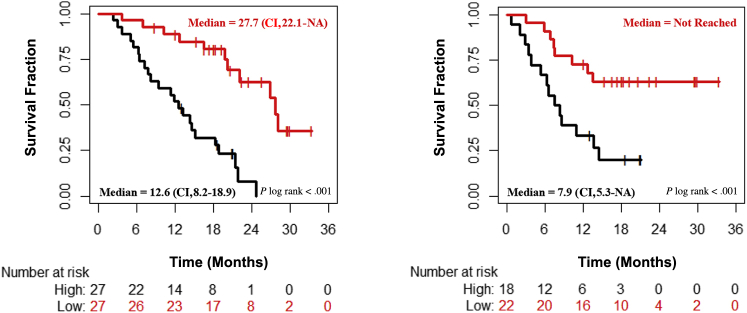
Kaplan–Meier Curves of Overall Survival (Left Panel) and Progression-Free Survival (Right Panel) Between the High (Red) and Low (Black) Risk Groups Created Using the Multivariate Baseline Model for Non–Small-Cell Lung Cancer